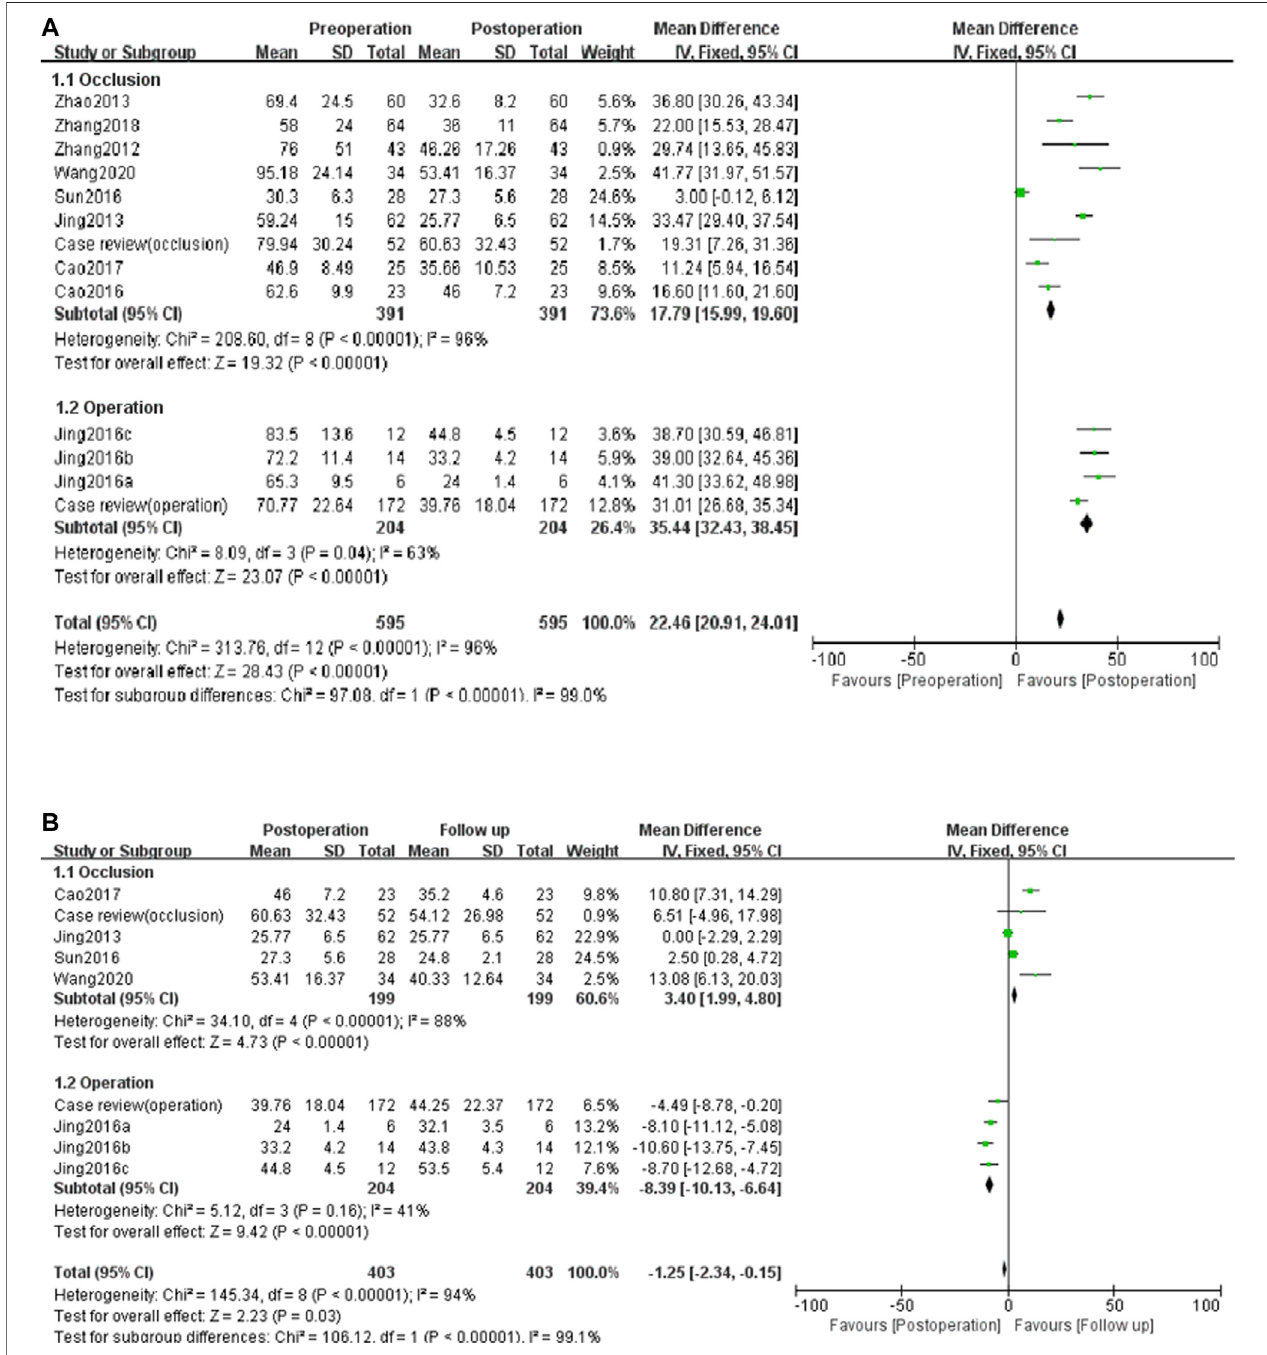
FIGURE 4 | Meta-analysis to compare the therapeutic effects (A) and prognostic effects (B) of different operation.